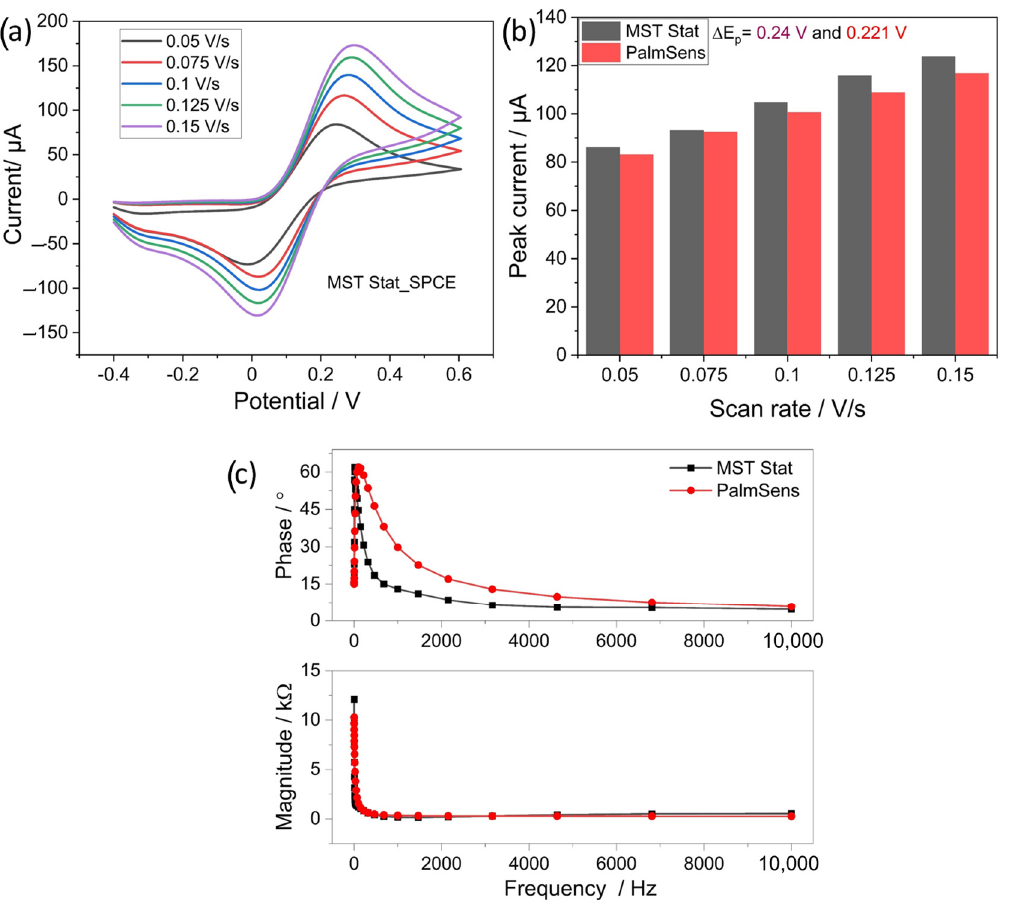
Figure 5. Validation of the developed MSTStat with PalmSens by ( a ) measurement of the CV of 5 mM K 3 Fe(CN) 6 ] 3 − /4 − solution on bare electrodes at different scan rates, ( b ) bar graph depicting the measured currents from both the potentiostat and ( c ) depicts the phase and magnitude plots of the bare electrode by PalmSens and MSTStat.